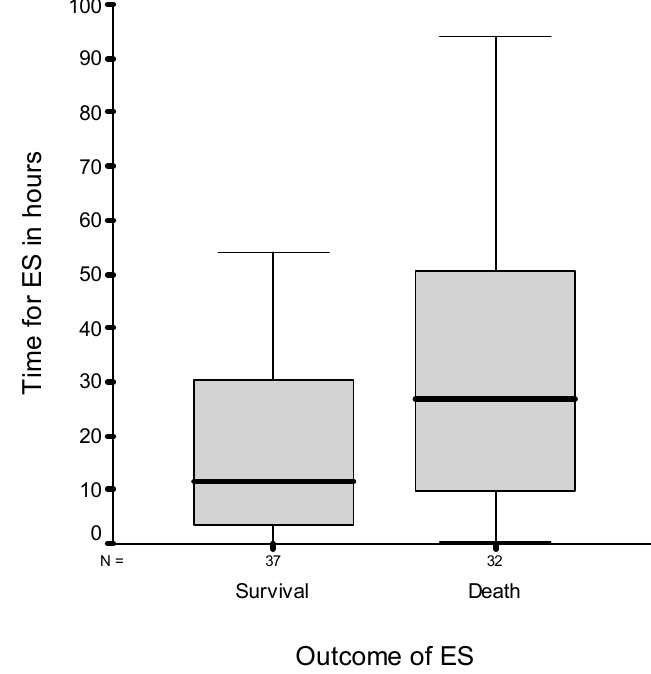
Figure 1. Time interval in hours for the occurrence of ES after the last melarsoprol application according to the final outcome. The inbox line in bold indicates the median. Outliers and extremes are not shown. Encephalopathic syndromes led to a fatal outcome in 32 patients (46.4%). On average, death occurred 2.5 days after diagnosis of the syndrome (median: 1 day; std. deviation: 2.9 days; range